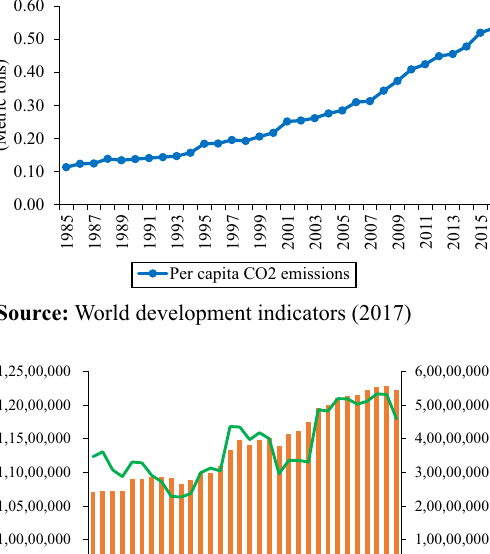
Figure 2. Cereal production